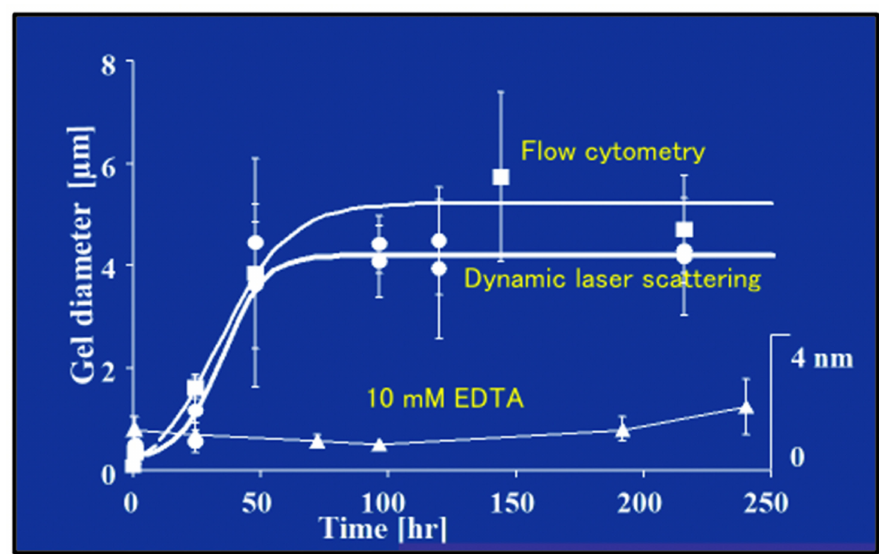
Figure 13. The Time course of DOM biopolymer assembly and MG formation is monitored by measuring particle size by both homodyne dynamic laser scattering (DLS), and by flow cytometry in 0.2 µ m-filtered SW. Measurements of microgel size by flow cytometry (squares) and DLS (circles) show a similar time course of assembly. MG size grows from colloidal, submicrometre size, to several micrometers following characteristic second order kinetics. Control samples in which MBP assembly was inhibited by chelating Ca 2+ by adding 10 mM EDTA to the SW gave an average size of 1–2.5 nm, regardless of the time of observation (triangles). Each point corresponds to the average ± SD. of five